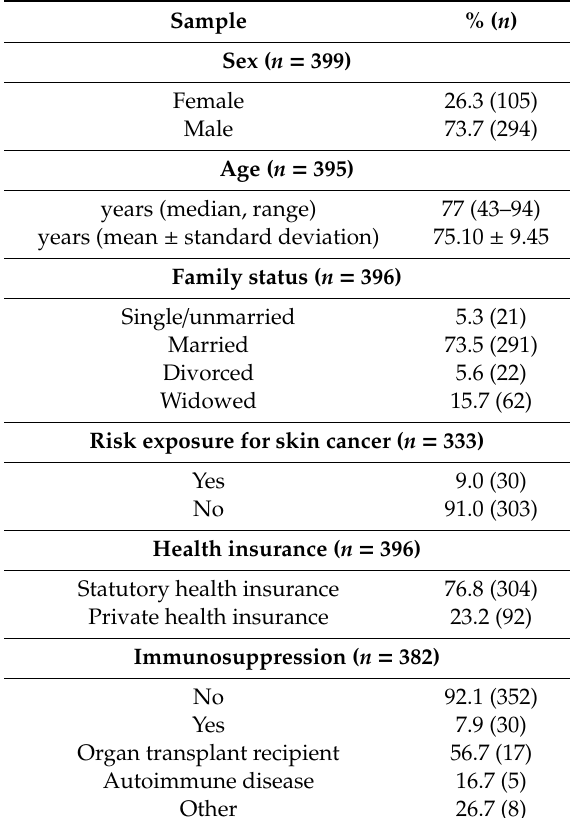
Table 1. Baseline characteristics of the study